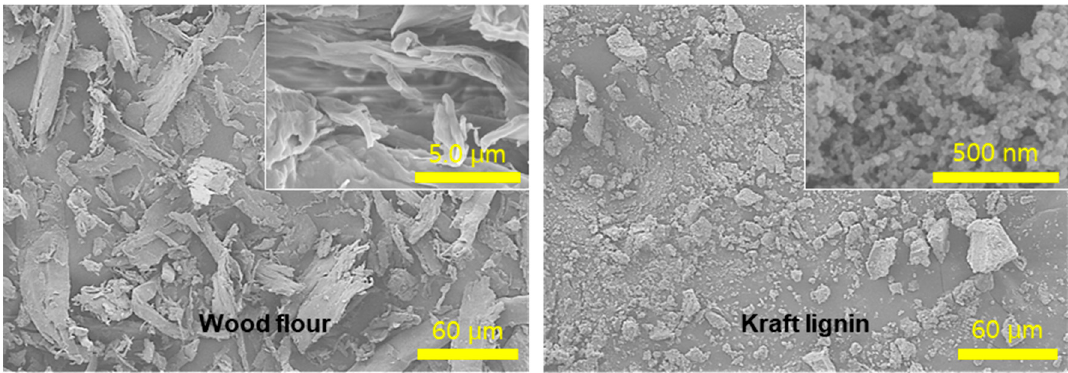
Figure 1. Scanning electron microscope (SEM) micrographs of the wood flour (WF) and kraft lignin (KL).